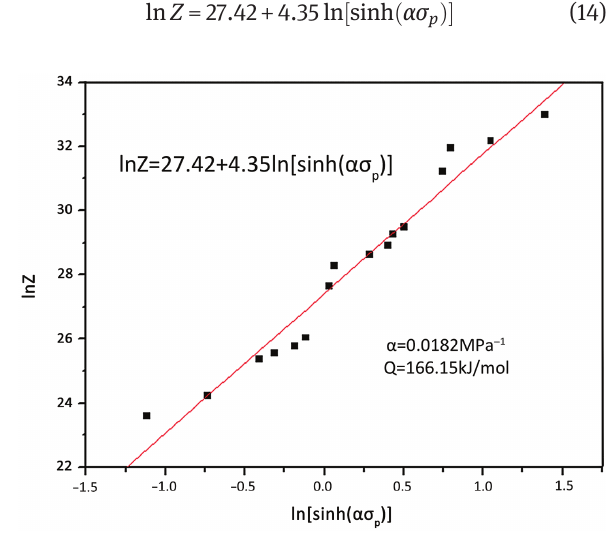
Figure 5: Relationship between Z parameter and flow stress of AZ81E